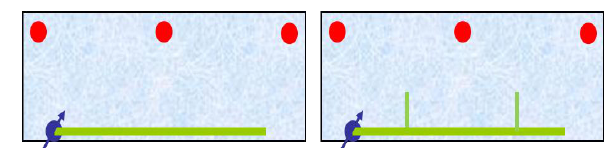
Figure 2—HPVI without fractures and with fractures